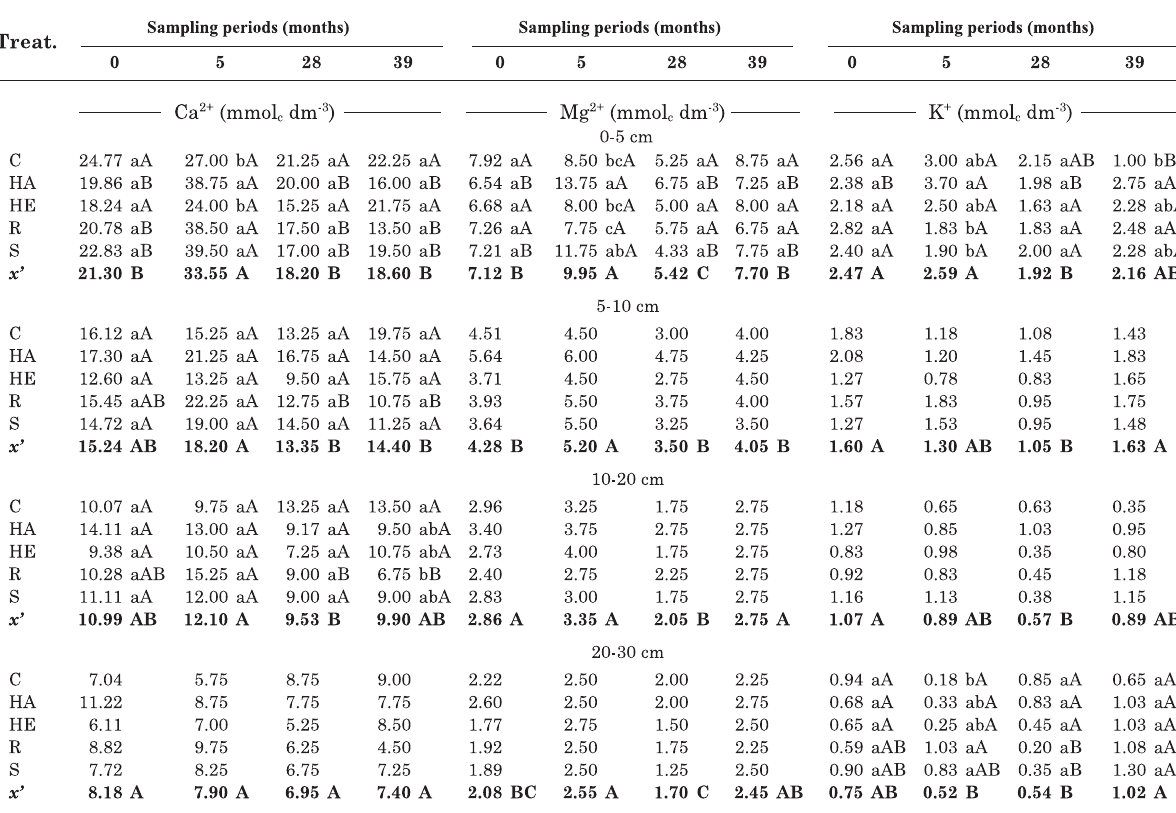
Table 5. Soil exchangeable cations in pasture recovery treatments in four sampling periods. Note: Fertilization applied in month 0, after soil